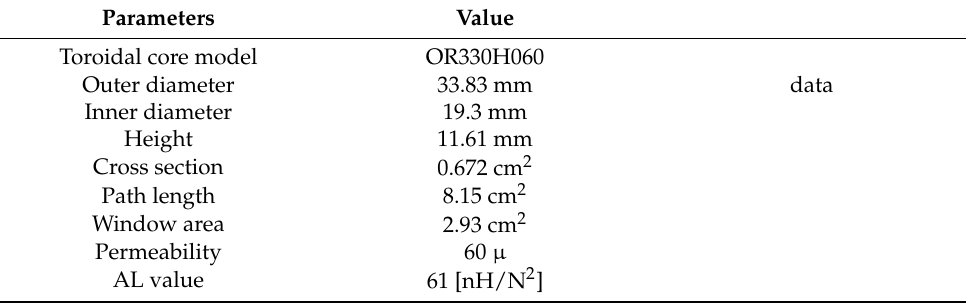
Table A3. Specifications of the toroidal core used to make the